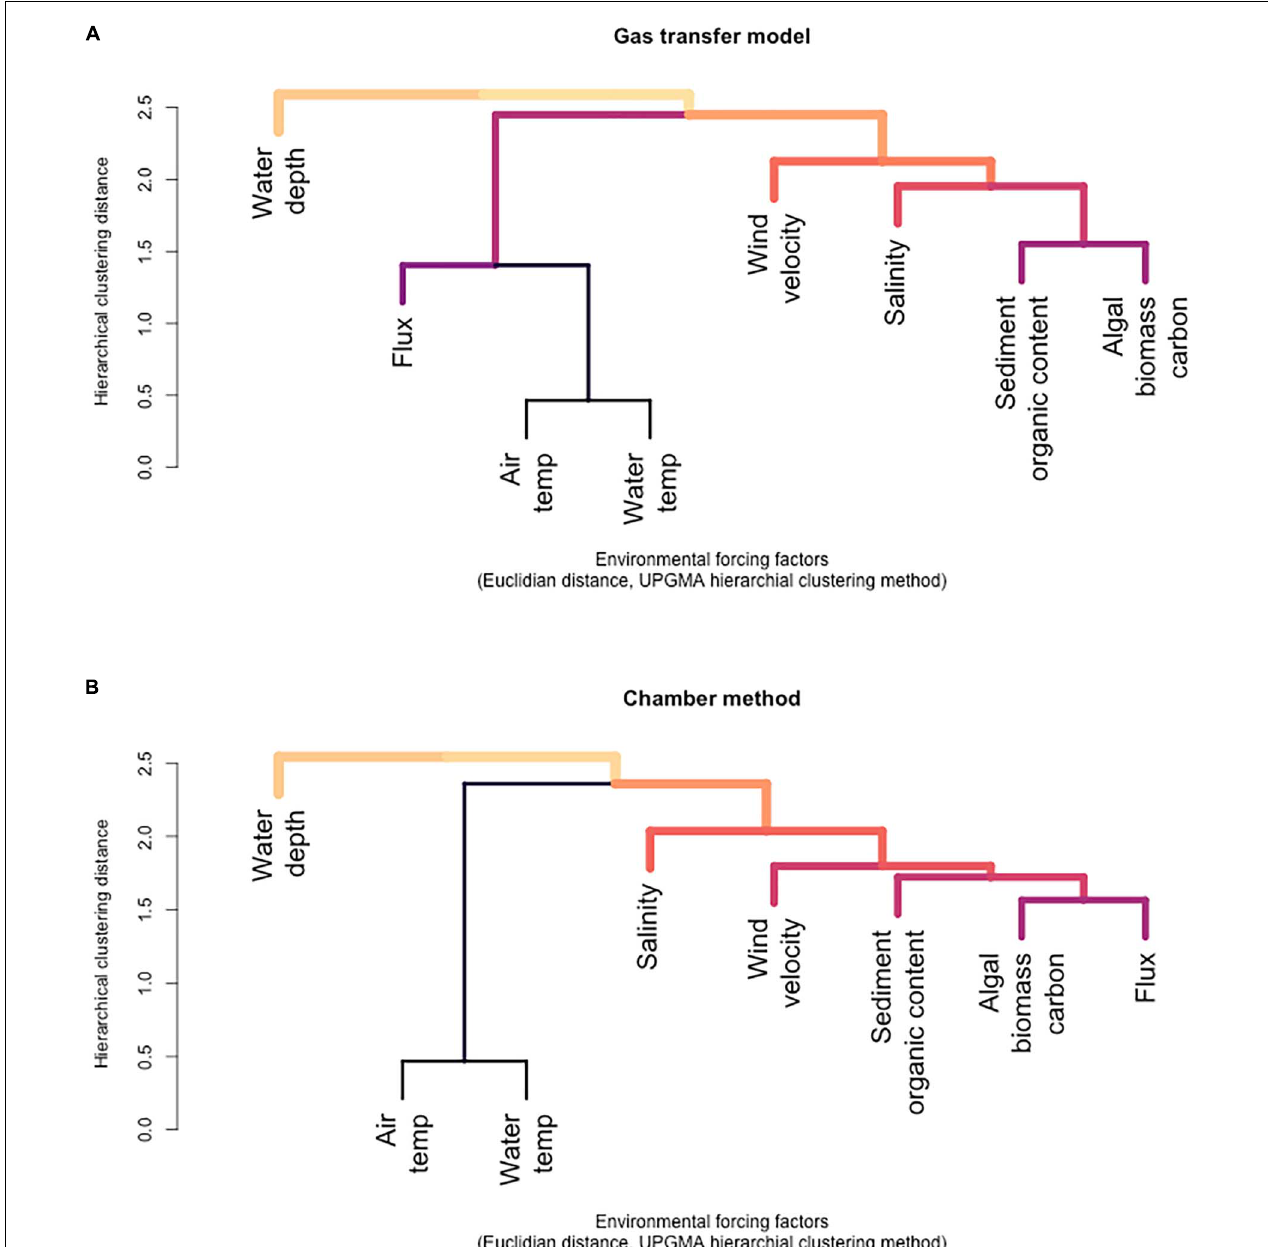
FIGURE 8 | Hierarchical clustering of environmental forcing factors and CH 4 flux calculated with the gas transfer model (A) and hierarchical clustering of environmental forcing factors and CH 4 flux calculated with the unshielded flux chamber method (B)